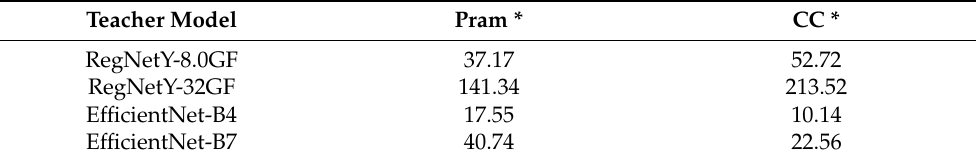
Table 5. Number of parameters and computational complexity of the teacher